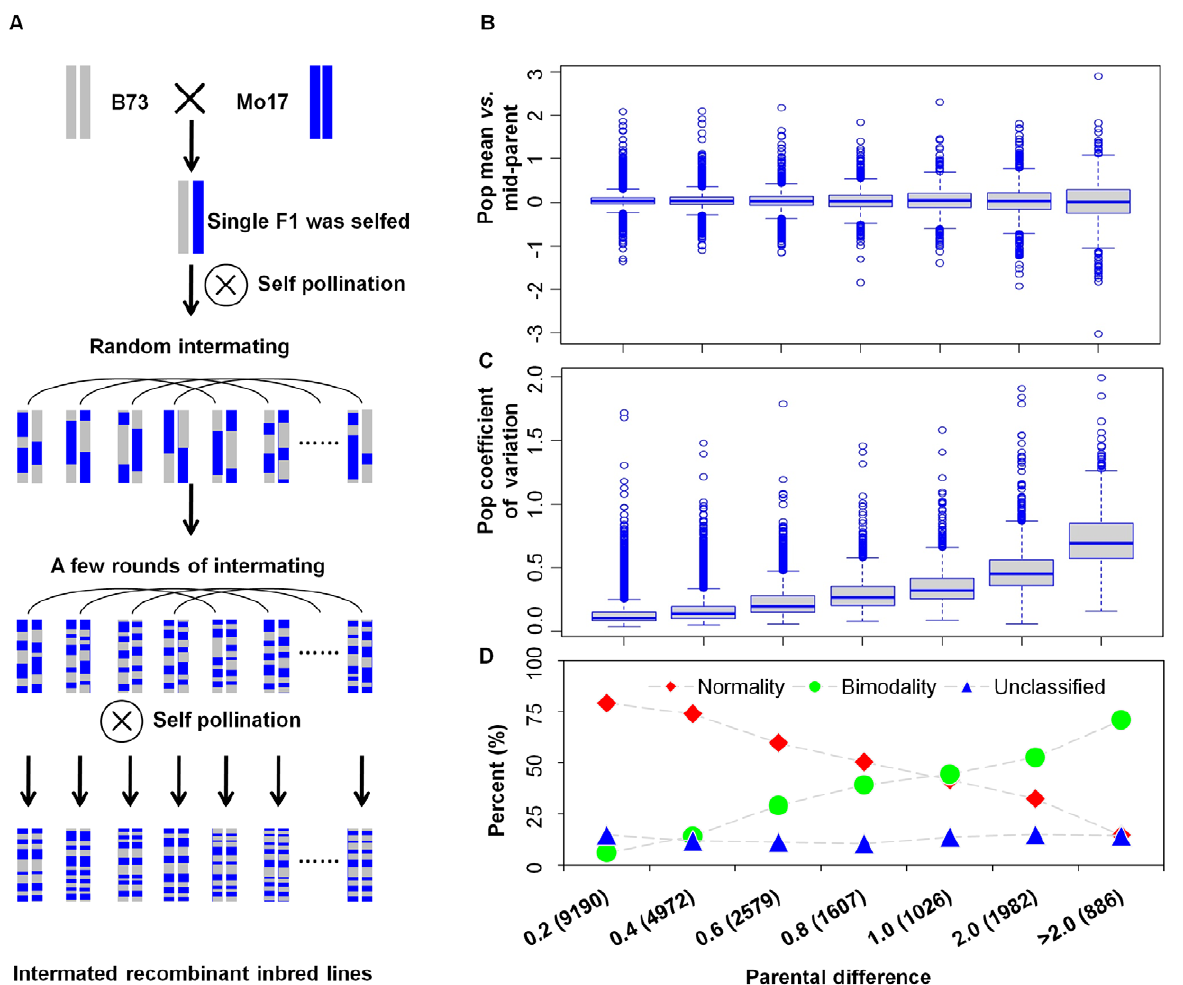
Figure 1. The intermated B73 6 Mo17 recombinant inbred lines (IBM RIL) and the relationship between expression variation in the RILs and expression fold change in the parents. (A) A schematic diagram of construction of the maize IBM RIL population (adapted from [50– 51]). In (B), (C) and (D), the x-axis is the absolute value of log2 of expression-level in B73 divided by the level in Mo17. The numbers in parenthesis show the gene numbers in each category. (B) The expression-level relationship between the population mean and the parental difference. The y-axis is the log2 value of population expression-level average divided by the mid parent value of genes representing the expression-level deviation from the parents. (C) The coefficient of variation (CV) for gene expression levels in the RILs was significantly correlated with the parental differences. The y- axis shows the coefficient of expression-level variation of genes in the IBM RIL population. (D) The type of distribution observed in the RILs is influenced by the scale of parental difference. The proportion of genes that exhibit normal, bimodal or unclassified distributions of expression levels in the RILs vary according to the level of differential expression in the parental genotypes.